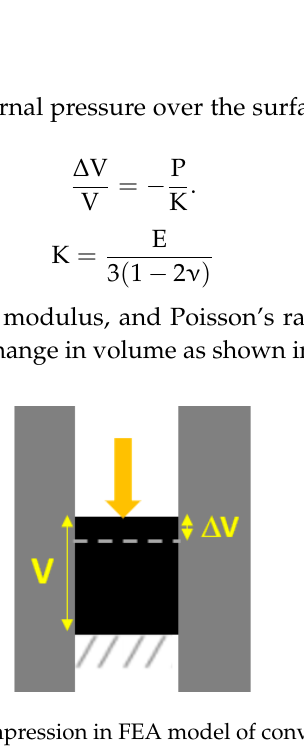
Figure 5. Volumetric compression in FEA model of conventional hanger seal.